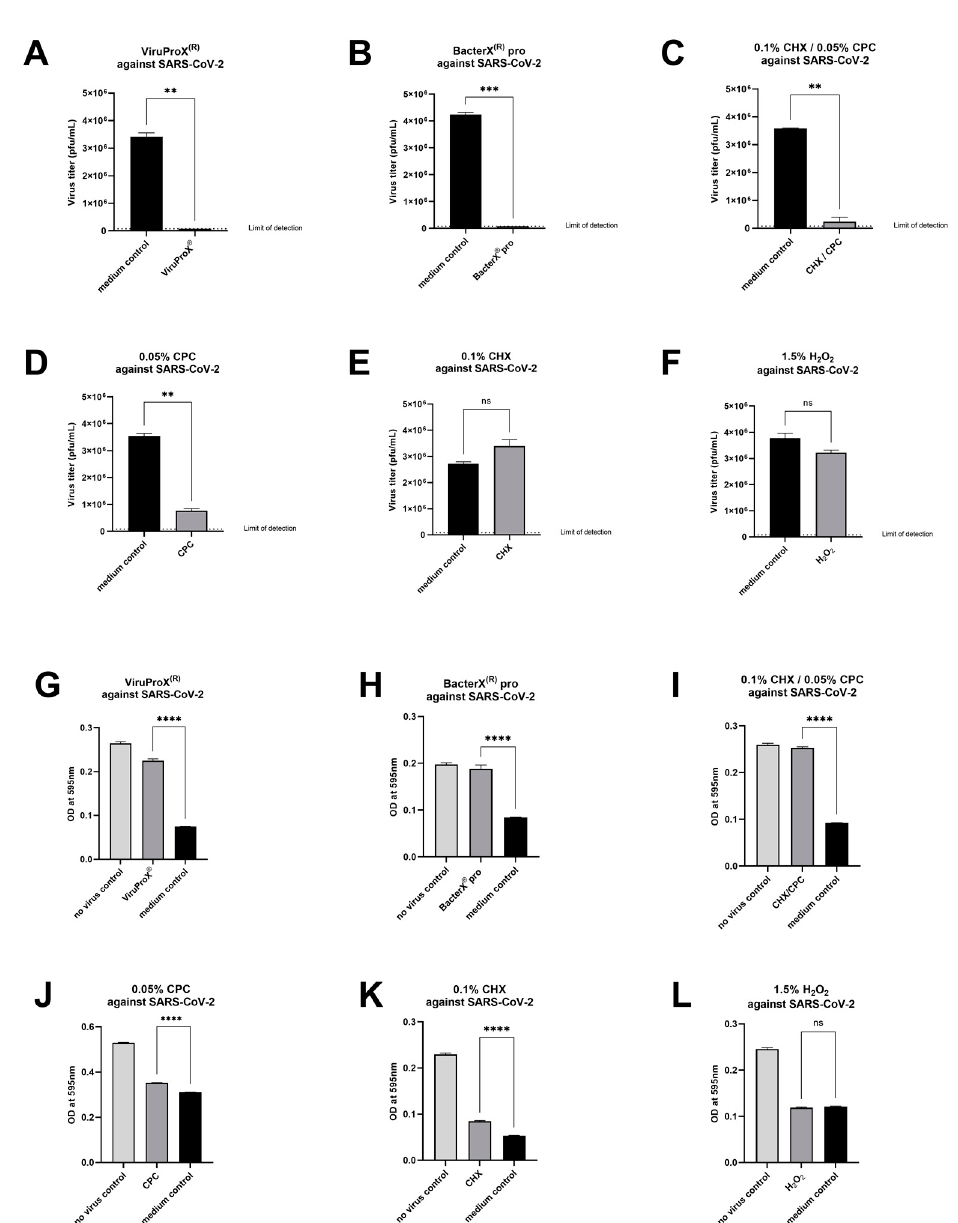
Figure 3. Determination of the virus titer and quantification of the cytopathic effect. The viral titer (pfu/mL) of the samples was determined by counting the plaques in each well ( n = 1–4). Statistical analysis was performed using unpaired t-test ( p > 0.05 (ns), p ≤ 0.01 (**), p ≤ 0.001 (***), p ≤ 0.0001 (****)) ( A – F ). The crystal violet staining of the cell layers was dissolved with methanol and the absorbance of the samples was measured at 595 nm. Staining of the no-virus control represents the intact cell layer and the medium control the maximal cytopathic effect. Statistical analysis was performed using one-way ANOVA with Tukey’s multiple comparisons test ( p > 0.05 (ns), p ≤ 0.01 (**), p ≤ 0.001 (***), p ≤ 0.0001 (****)) ( G – L